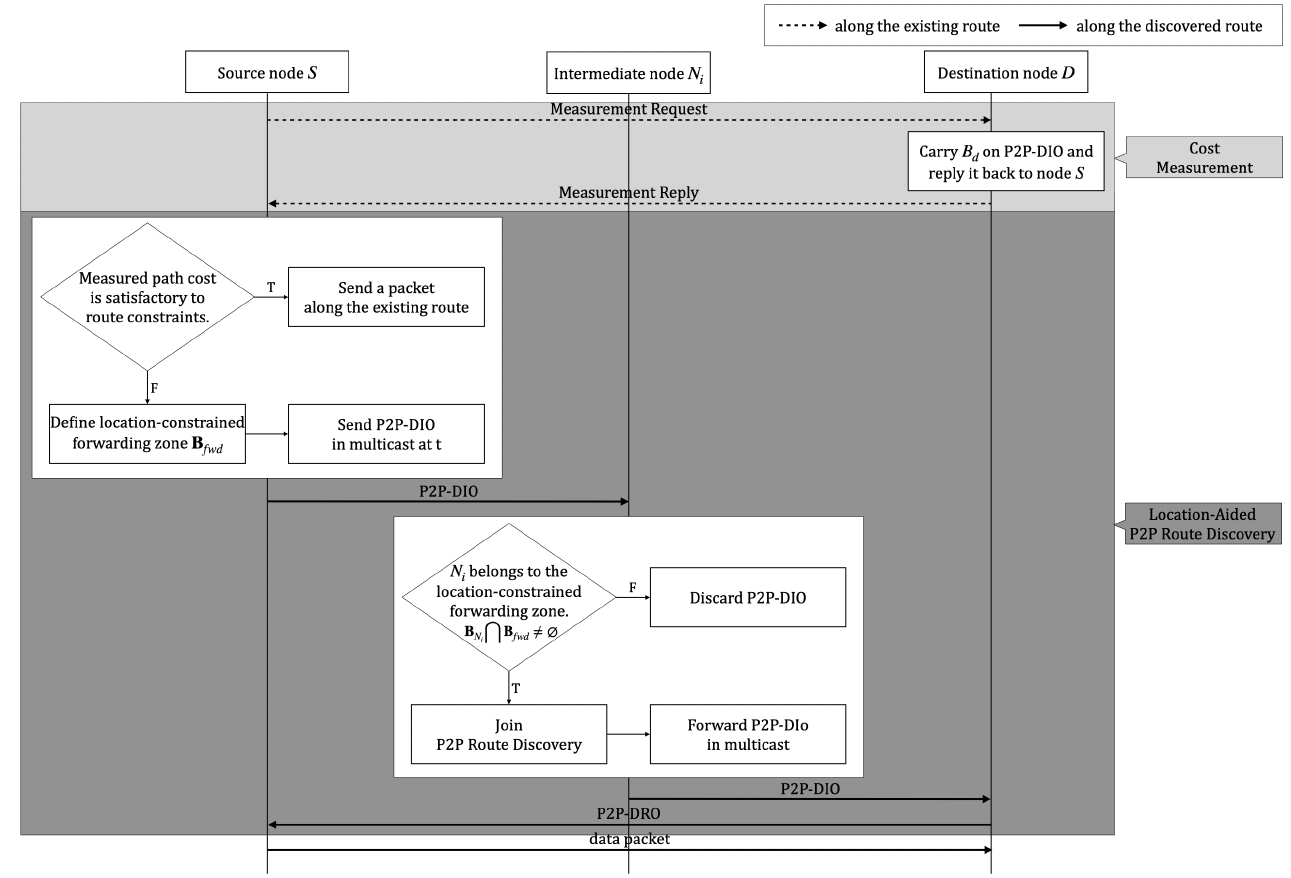
Figure 2. The flowchart of the proposed